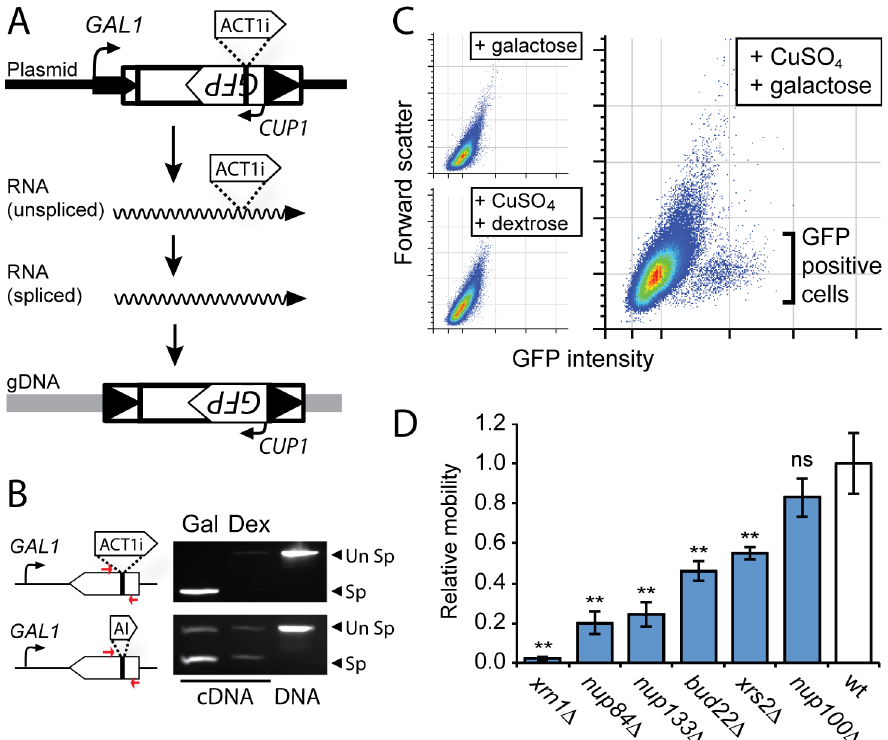
Fig 3. A novel GFP-based reporter of Ty1 mobility. (A) An overview of the GFP-tagged Ty1 plasmid. Ty1 transcription is induced by activation of the GAL1 promoter that produces a long Ty1 transcript including an internal GFP gene and an ACT1 intron (ACT1i). The spliced transcript has the ACT1i removed, which then provides a template for Ty1 protein production and reverse transcription. Ty1 cDNA is imported into the nucleus and integrated into the S . cerevisiae genome. The GFP gene is then induced from the CUP1 promoter by CuSO 4 to report successful integration events. (B) RT-PCR was used to assess splicing of RNA with ACT1i versus an artificial intron (AI) within the GFP gene (primer positions marked by red arrows). Spliced RNA transcripts (Sp) were mainly detected upon induction of the transcription by the GAL1 promoter using galactose (Gal). Growth on dextrose (Dex) inhibits the GAL1 promoter and the production of RNA transcripts. Plasmid DNA was used as a positive control to allow the PCR amplification across intron-containing GFP . “Un Sp” indicated the detection of unspliced RNAs. (C) Flow cytometry analysis shows that GFP is only expressed under conditions of galactose induction of Ty1 expression followed by CuSO 4 induction of GFP .(D) The effect of six different gene deletions on Ty1 mobility, relative to wild-type S . cerevisiae . The relative mobility was measured as a percent of GFP positive cells after induction of the Ty1-GFP reporter, and was repeated independently, three times (error bars: standard error, n > 3; (cid:3)(cid:3) Tukey–Kramer method, p < 0.05). All values are normalized to